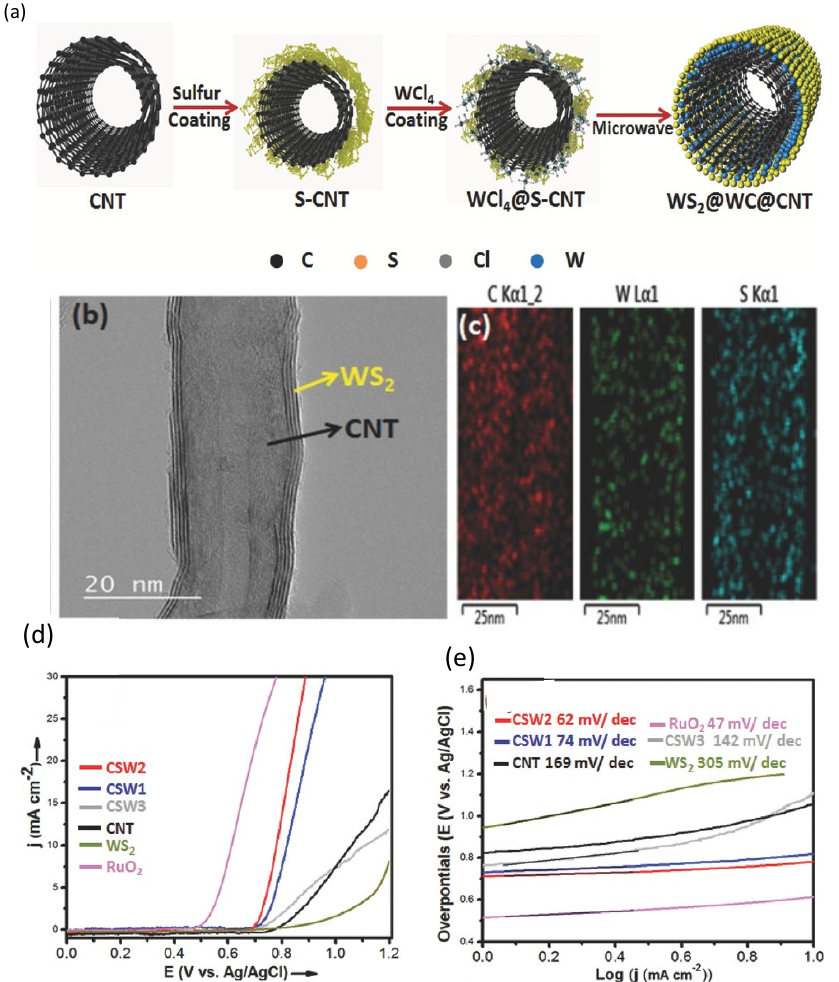
Figure 12. ( a ) Schematic illustration of the synthesis of WS 2 sheets on the surface of CNT. Microstructure characterization of the heterostructure. ( b ) HRTEM image. ( c ) EDX map. Electrocatalytic activity for OER. ( d ) LSV of different WS 2 /CNT heterostructures with different WS 2 amounts, in comparison with the pristine materials. ( e ) Tafel curves of the different